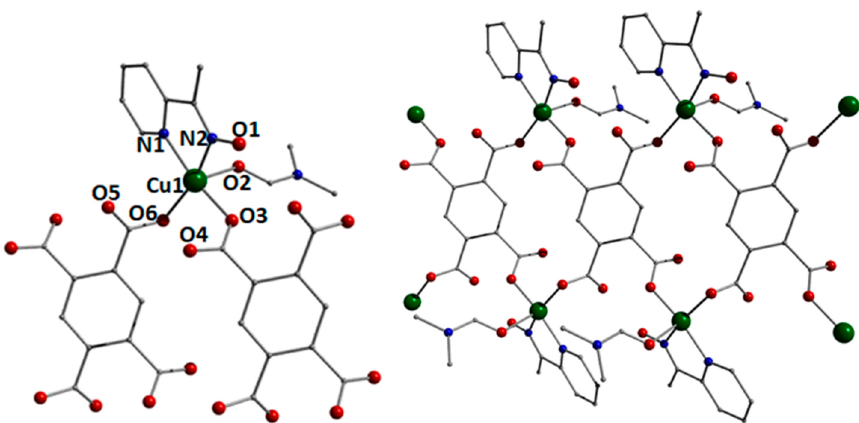
Figure 6. Representation of the repeating unit ( left ) and a part of the 1D double chain of 8 ( right ). Color code: Cu II , green; N, blue; O, red; C, grey. The hydrogen atoms are omitted for clarity.